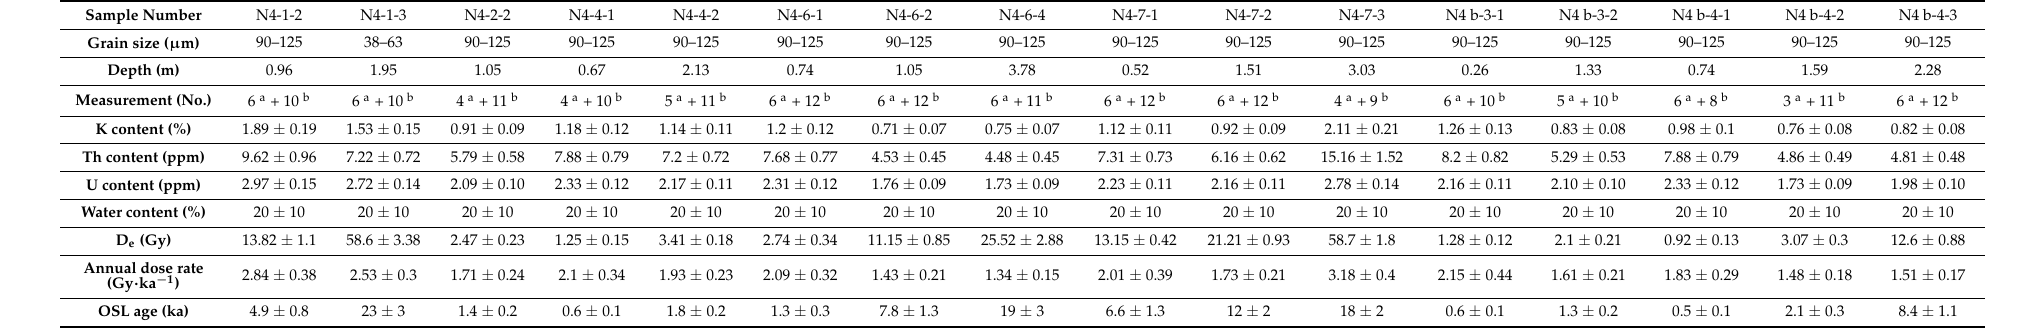
Table 3. Sample information, annual dose rate, and OSL ages: a and b are the number of aliquots measured using SAR and SGC methods,